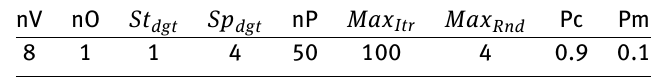
Table 27: VSSCGA Settings for Powel’s function with 8 variables